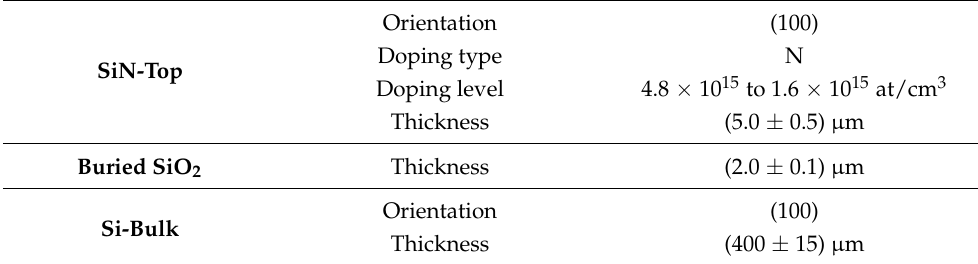
Table 3. Silicon-on-insulator wafer characteristics provided by the